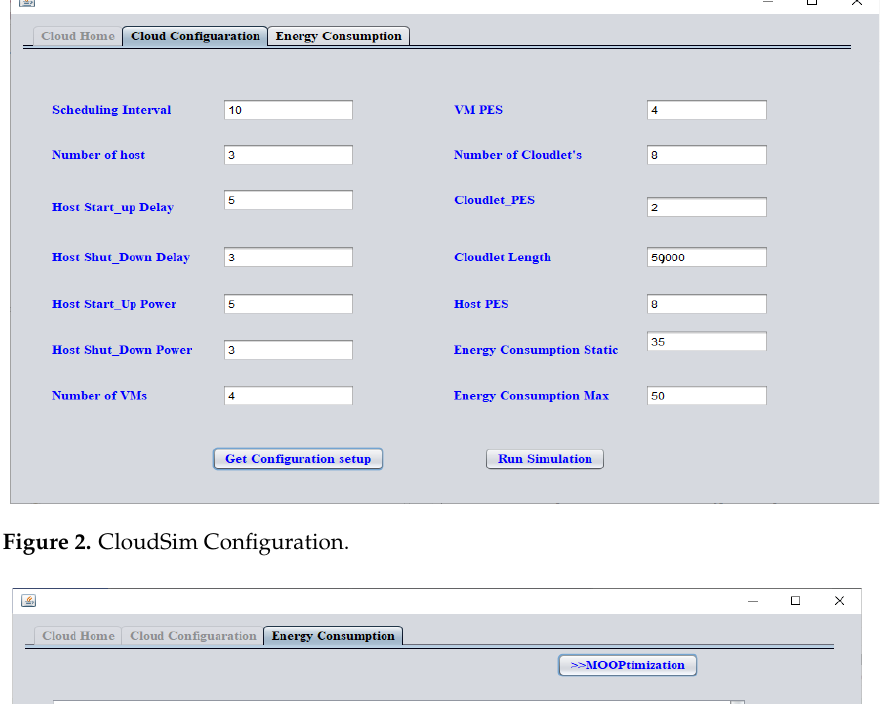
Figure 2. CloudSim Configuration.